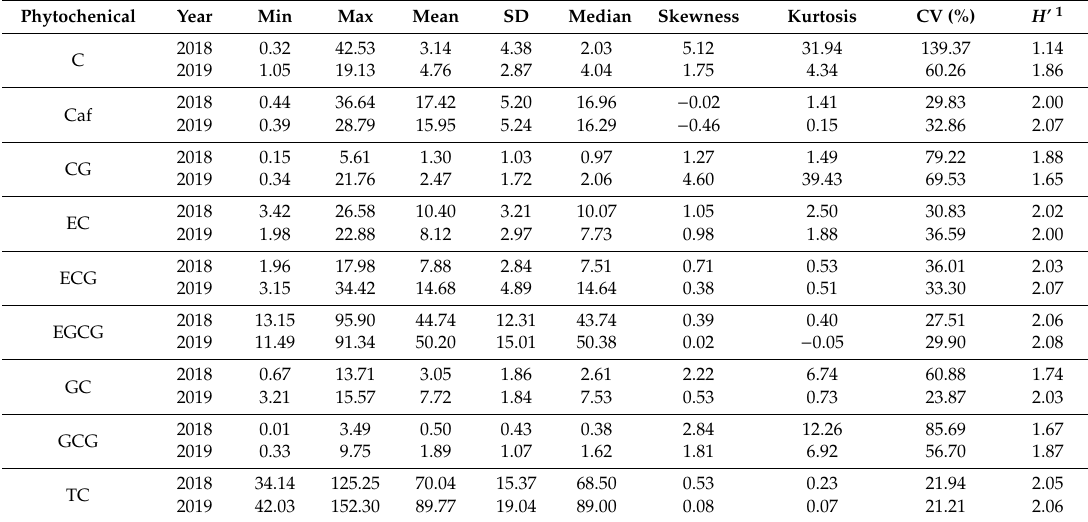
Table 1. Variation and distribution of phytochemical contents (mg / g) in the 462 tea accessions. Phytochenical